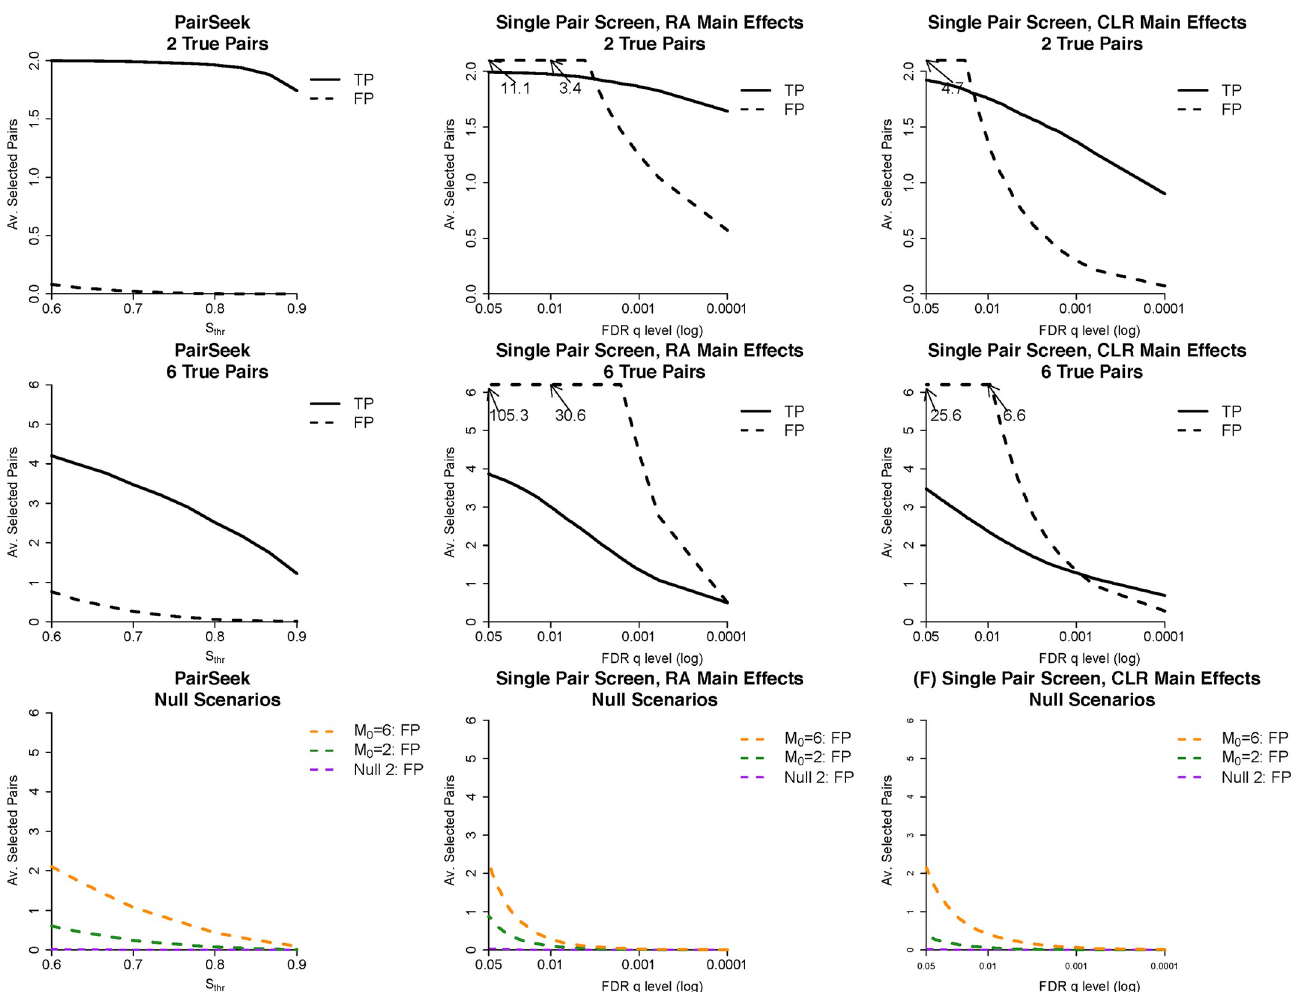
Fig 2. Operating characteristics of PairSeek and the FDR-adjusted single pair screens, which adjusted for main effects using either relative abundance (RA) or the centered log-ratio transformation (CLR). The top row shows the average number of true and false positives (TP and FP, respectively) across different values of the selection threshold for M = 2 under the Alternative scenario for PairSeek along with the two single pair screens for different FDR thresholds. The second row are parallel results for M = 6. The last row shows the performance of the three methods for scenarios Null 1 ( M 0 = 2 or 6 main effects only) and Null 2 (no association between the microbiome and generated